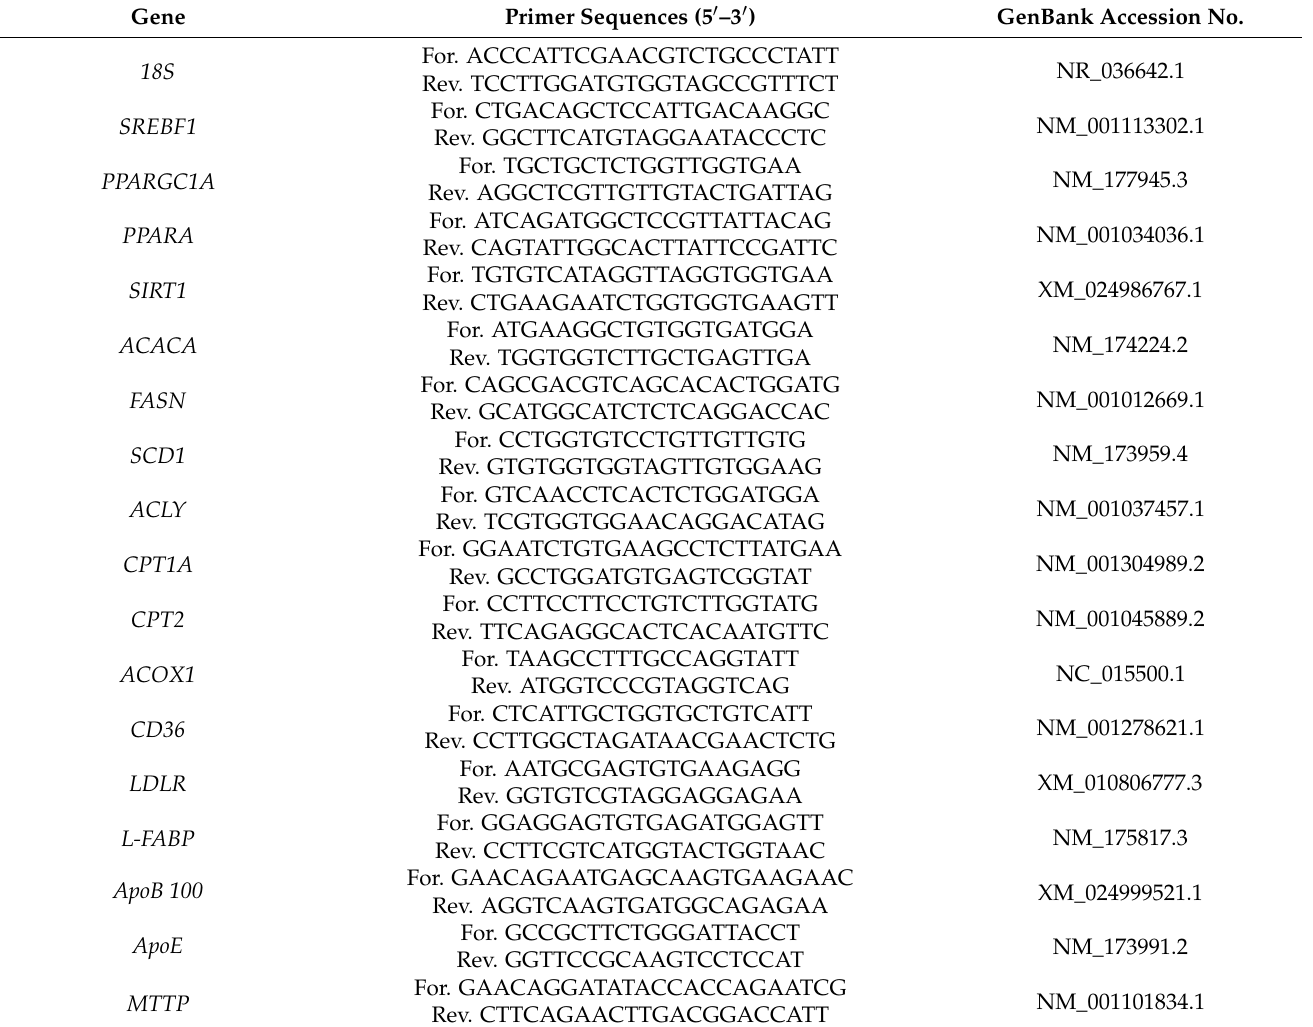
Table 1. Primer sequences for